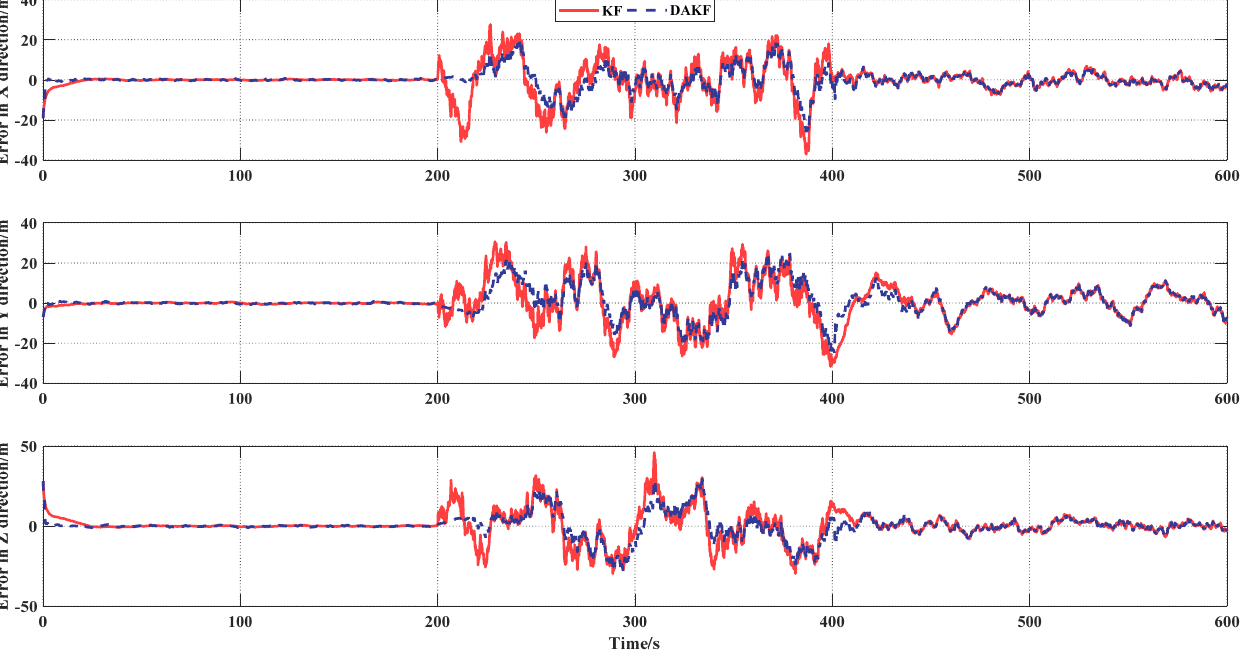
Figure 6. Position error of the two algorithms. Table 2. Average position error.